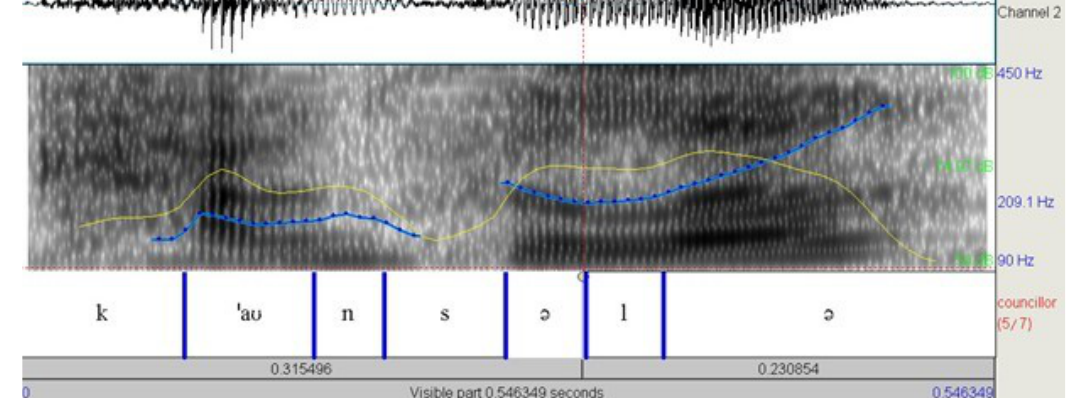
Figure 5 - Configuration of the Rise produced by a HKE female speaker